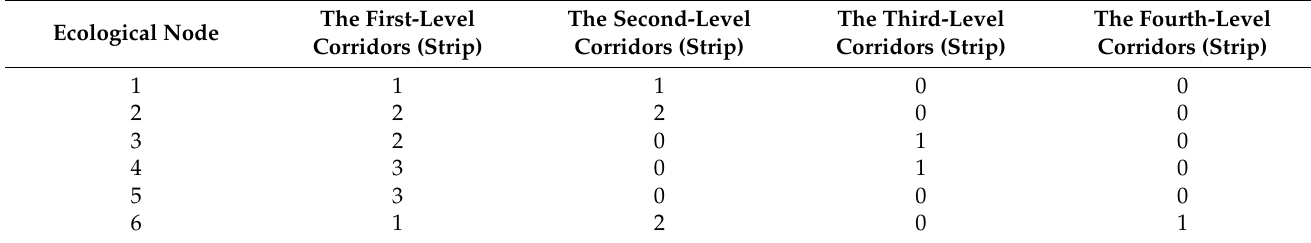
Table 4. Number of ecological corridors connected by ecological nodes at each level. The First-Level The Second-Level The Third-Level The Corridors (Strip) Corridors (Strip) Corridors (Strip) Ecological